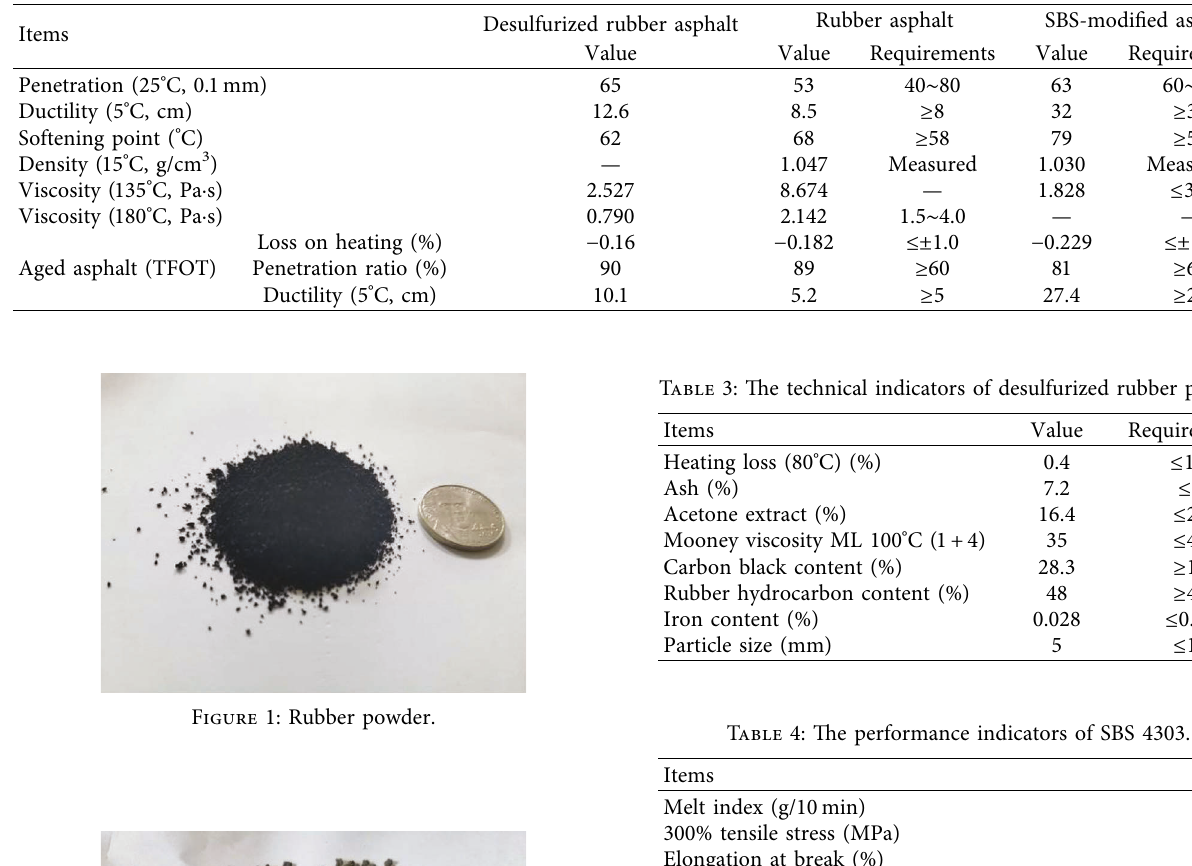
Table 2: The performance technical indicators of three kinds of modified asphalt.